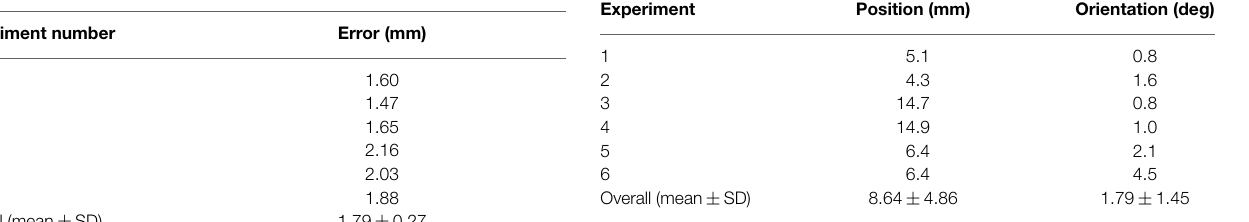
TABLE 1 | US image-based 3D positional patient setup errors for experiments 1 through 6 .